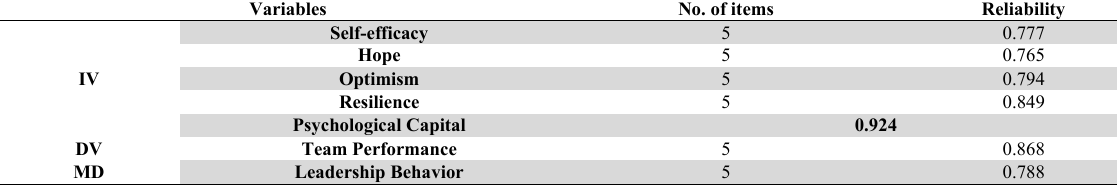
Reliability analysis (Cronbach’s Alpha) results for all research variables